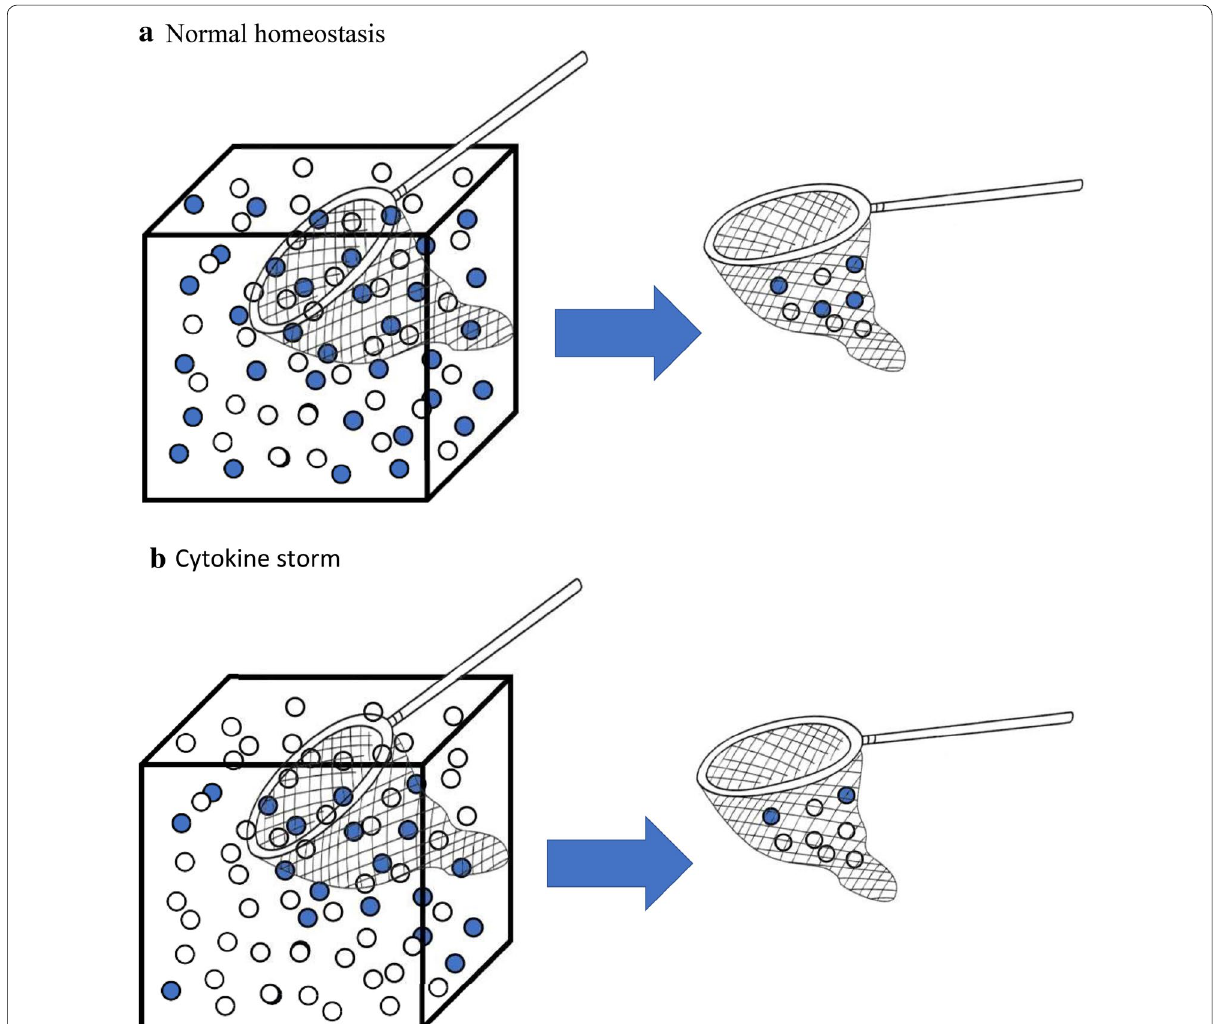
Fig. 3 The rationale of bulk removal of cytokines during cytokine storm. When homeostasis is normal, the pro‑inflammatory (open circles), and anti‑inflammatory (closed circles) mediators are in balance, molecules are present evenly as demonstrated in the first panel of the figure ( a) . When molecules are adsorbed in this scenario, the removal rate of both should be similar. However, if one component is in abundance—which is the case during cytokine storm ( b ), then the removal rate should be proportionally higher from the mediator that is present in large numbers. This demonstrates the rationale why bulk removal of cytokines during cytokine storm may help to regain homeostatic